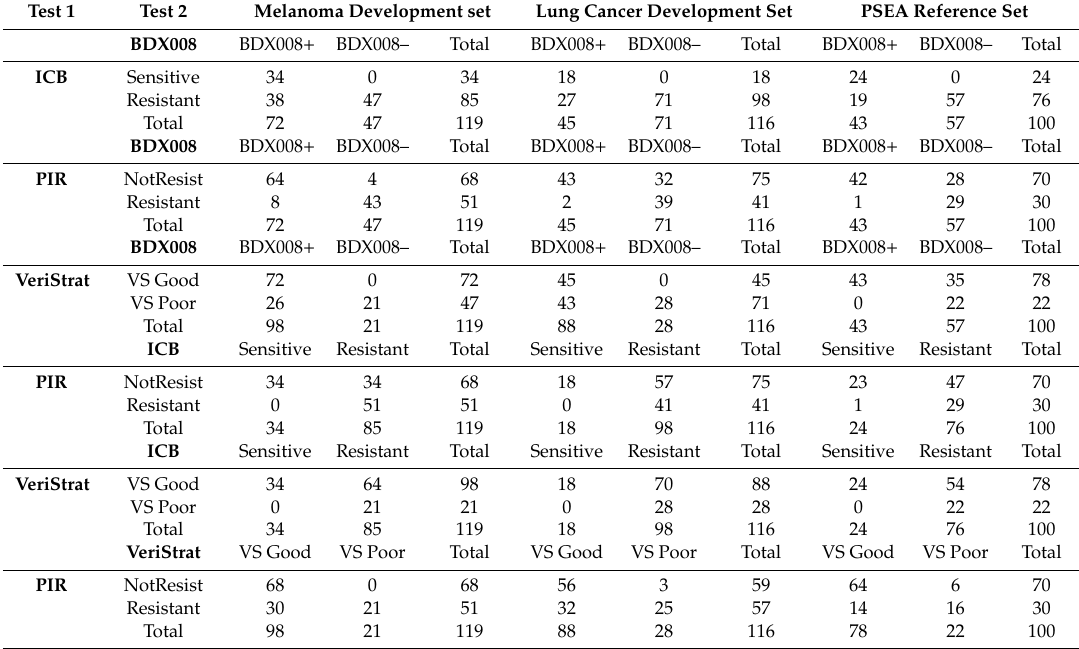
Table 4. Distribution of number of patients with pairwise classification assignments by sample set for all pairs of the four